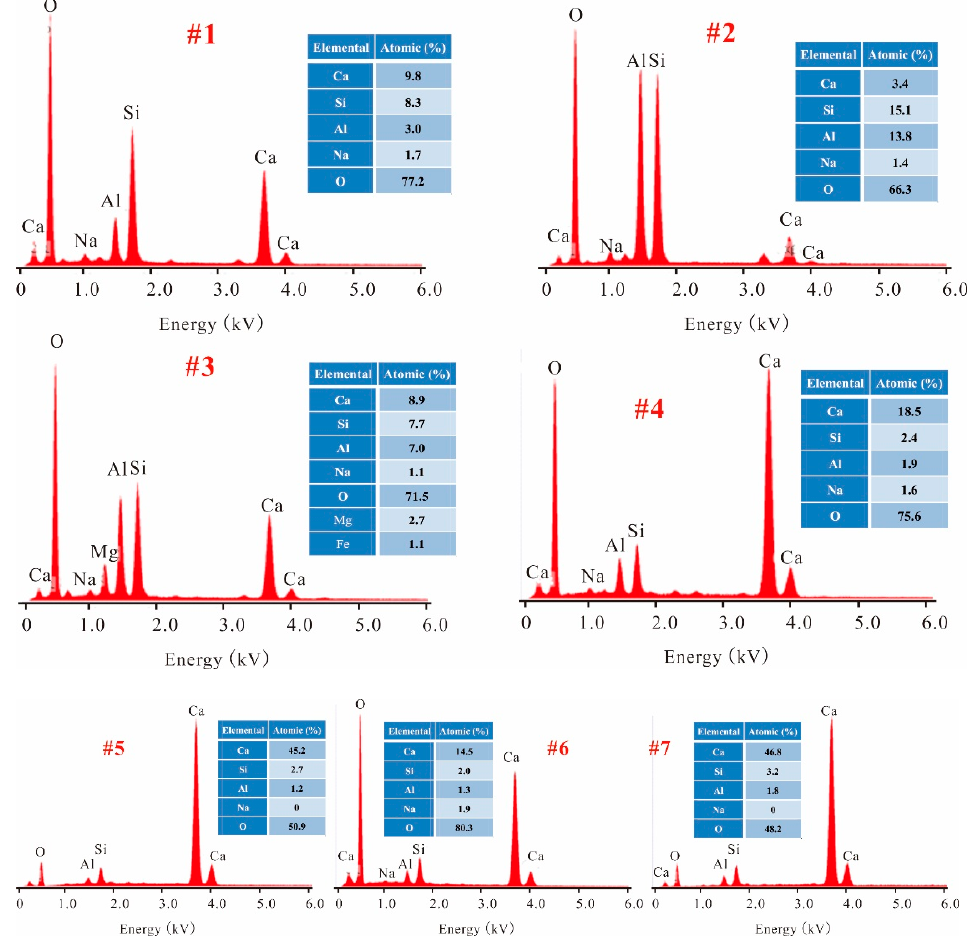
Figure 9. The EDX spectra of selected spots #1 – 7 indicated by circles in Figure 8.